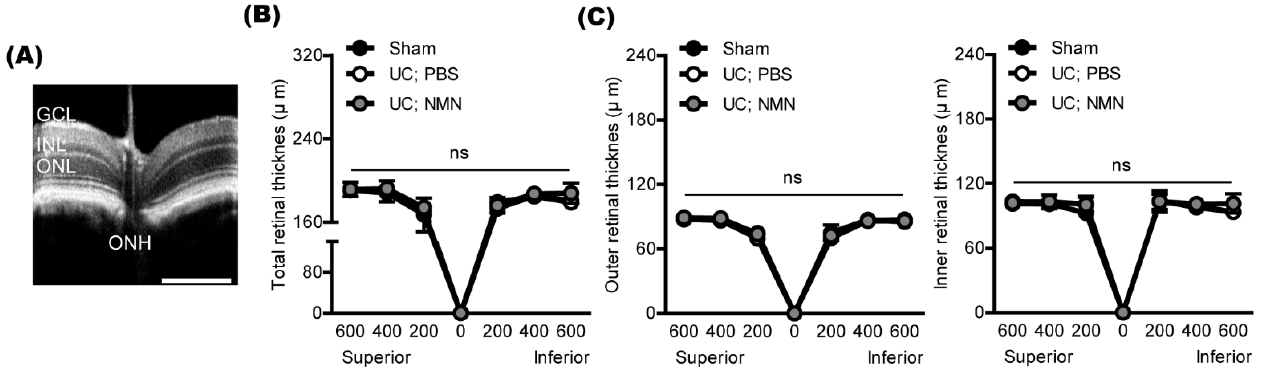
Figure 4. Screening of alterations in retinal thickness by NMN treatment. ( A ) A representative retinal picture of the optical coherence tomography (OCT). GCL, the ganglion cell layer; INL, the inner nuclear layer; ONL, the outer nuclear layer; ONH, the optic nerve head. Scale bar, 500 μ m. ( B , C ) Quantitative analyses showed that NMN treatment did not change retinal thickness in UCCAO-operated mice, analyzed at 200, 400, and 600 μ m from ONH (n = 5–6 per group). ns, not significant. Two-way ANOVA followed by a Bonferroni post hoc test. Graphs are shown as mean ± standard deviation. UC, UCCAO.